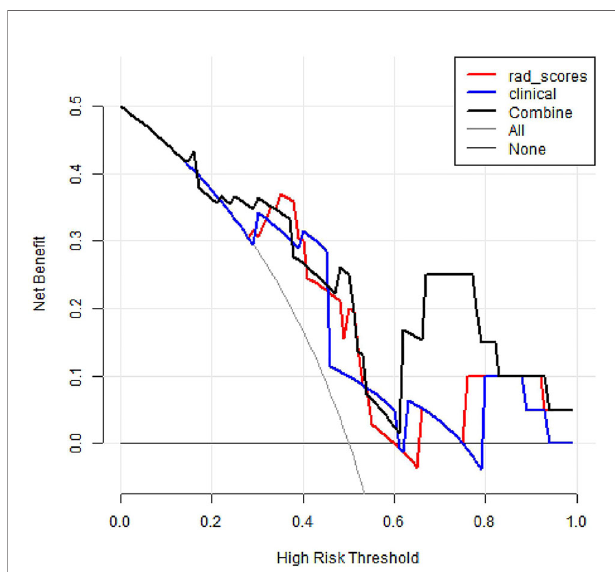
FIGURE 7 | Decision curve analysis of three models. The y-axis measures the net bene fi t. The black thick line represents the radiomics nomogram. The red thick line represents the radiomics score. The blue thick line represents the clinical model. The gray line represents the assumption that all patients gained substantial bene fi t after NAC. The horizontal black thin line represents the assumption that no patients gained substantial bene fi t after